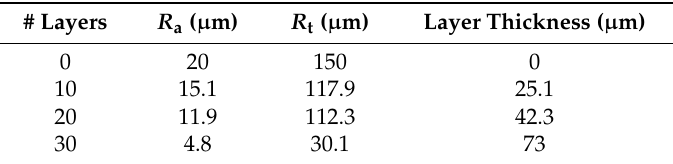
Table 2. Roughness results for the initial substrate before coating and after applying 10, 20, and 30 layers of coating.